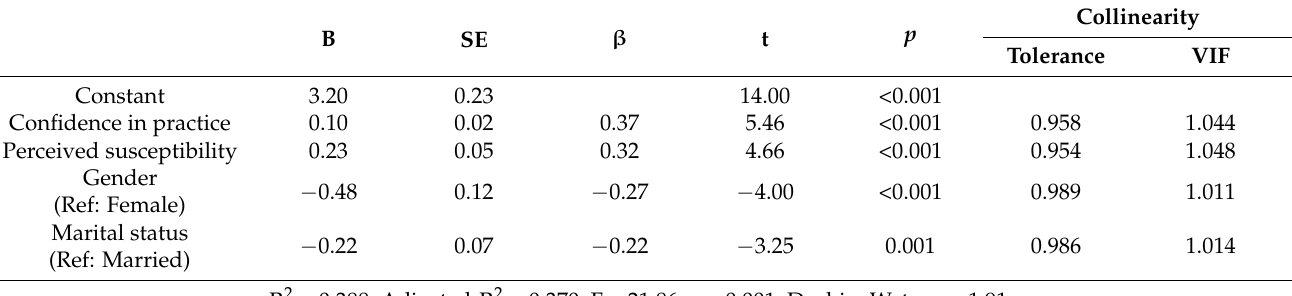
Table 4. Factors affecting COVID-19 infection control practices ( n = 143).